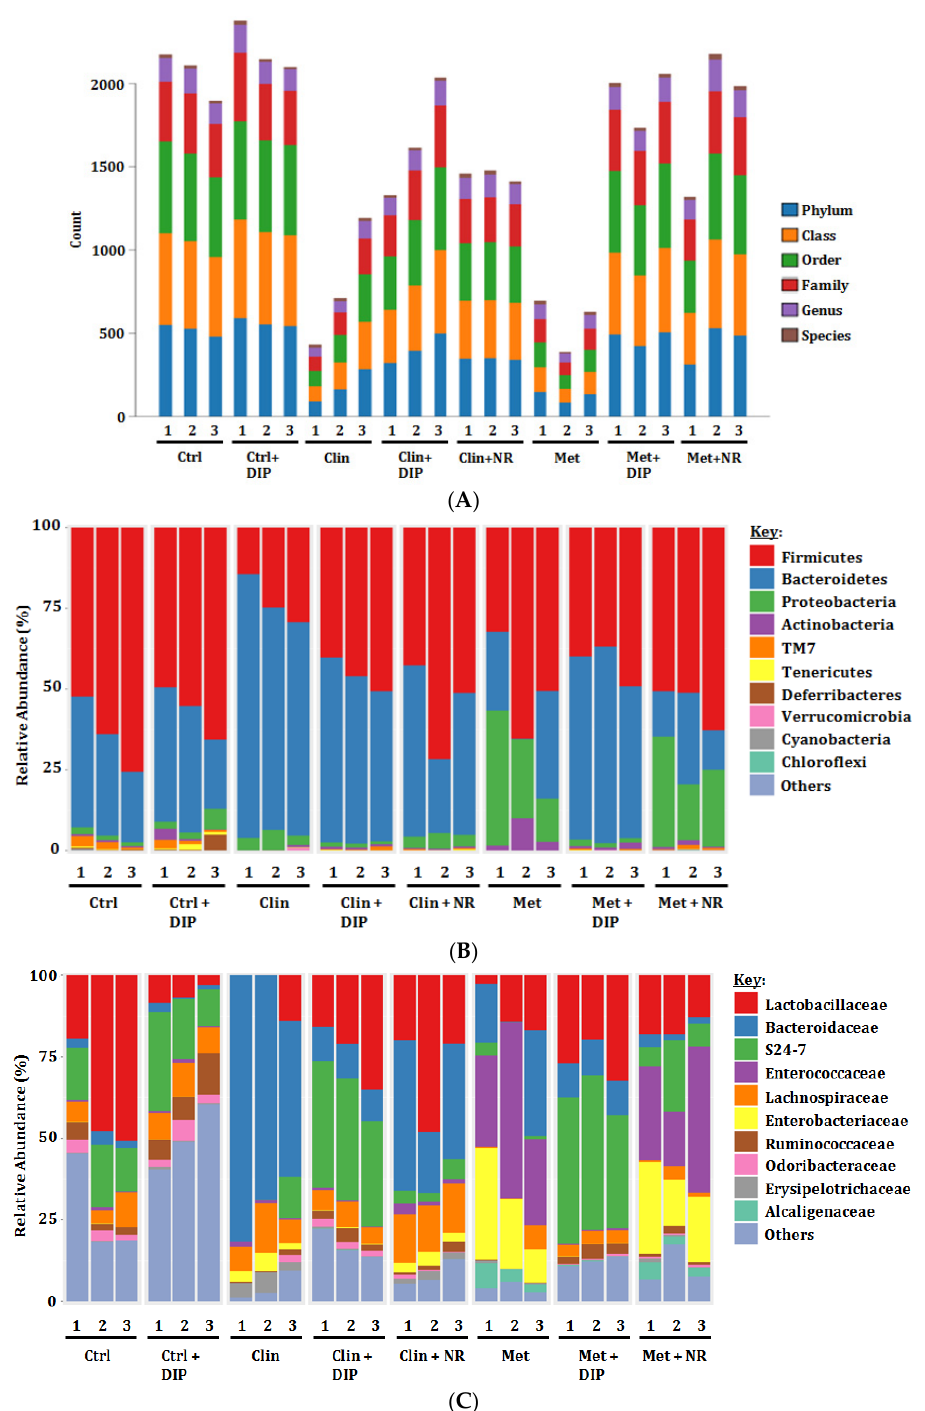
Figure 5. Taxonomic summary of fecal samples by Illumina miSequencing of 16S rRNA. ( A ) The taxonomic levels of phylum, class, order, family, genus, and species in individual samples ( n = 3). The abscissa represents samples and the ordinate represents the number of OTUs. ( B ) Relative abundance (%) at the phylum level of each group under different treatment conditions ( n = 3 per group). ( C ) Relative abundance (%) of the microbial community at the family level in different treatment groups ( n = 3 per group).